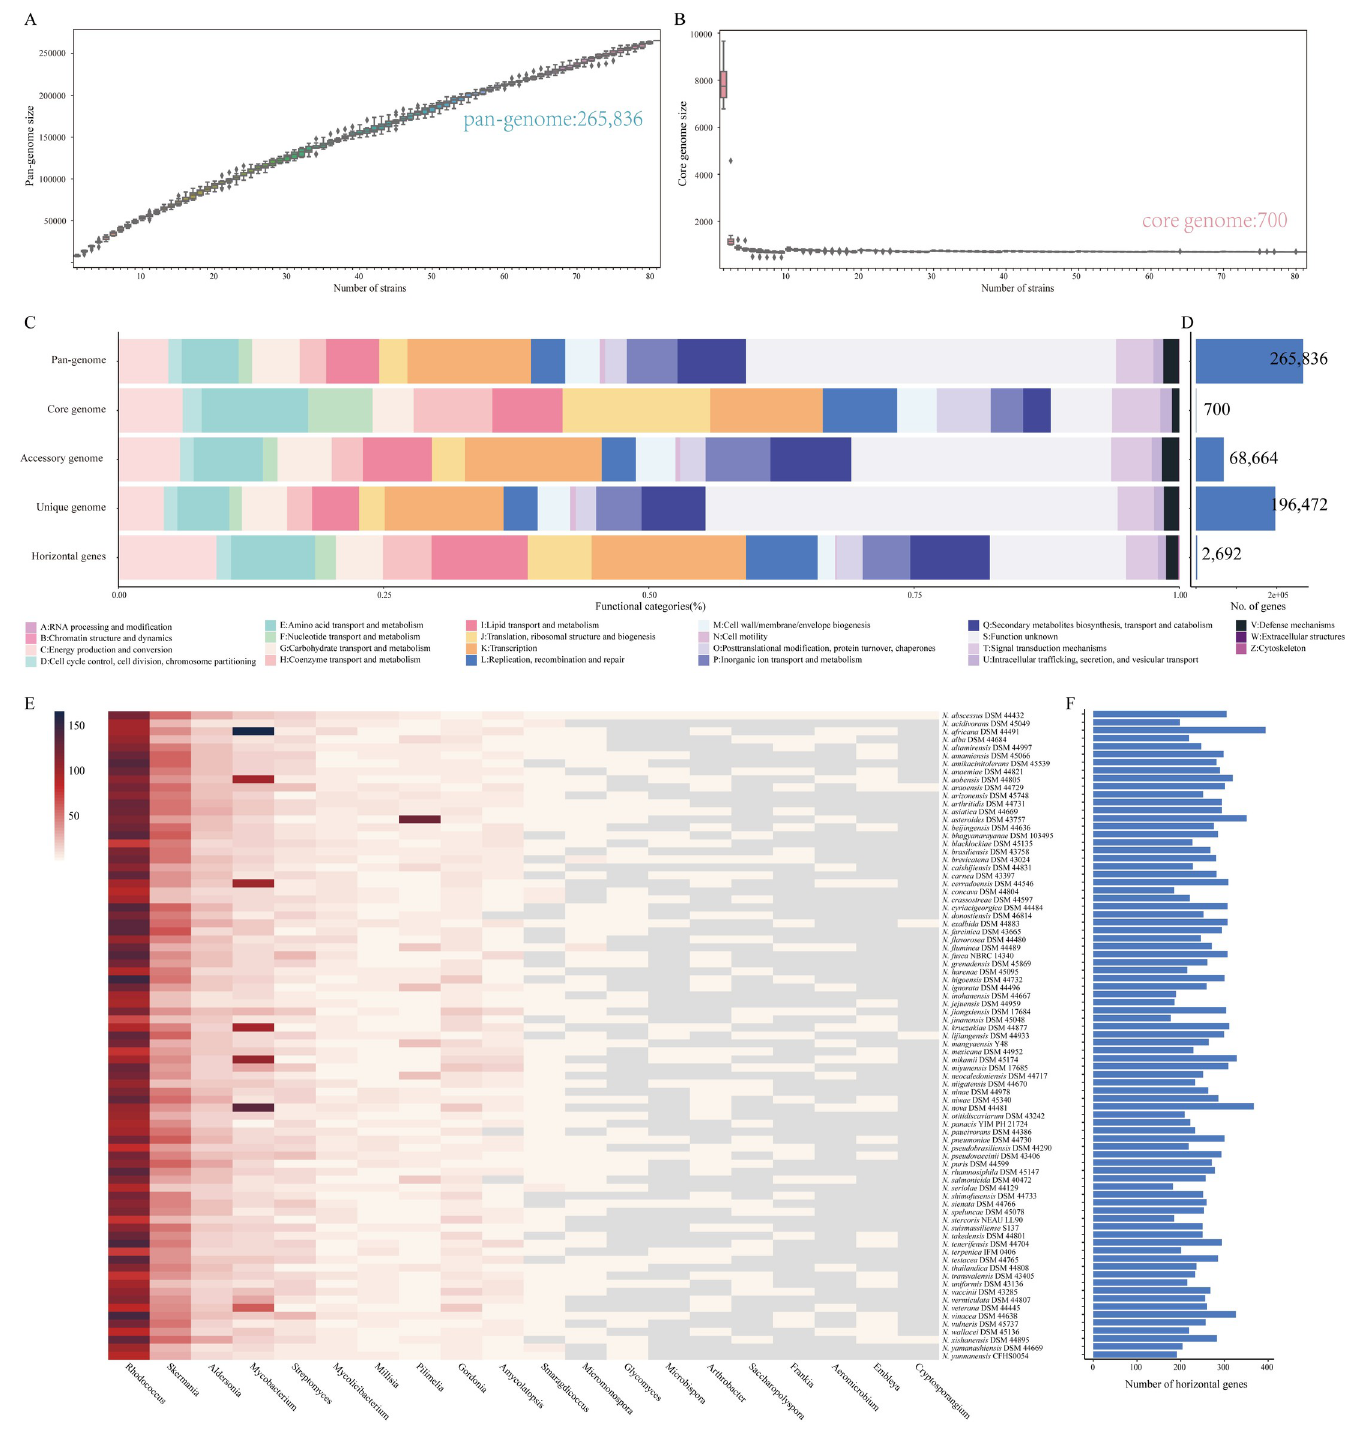
Fig 1. Pan-genome structure and function of type strains of Nocardia . (A) Gene accumulation curves for the pan-genome. (B) Gene accumulation curves for the core genome. The cumulative sizes of the pan-genome and core genome were calculated by type strains without replacement in random order 1000 times and then used to calculate the mean size. Error bars indicate one standard deviation from the mean. Five synonymous species were removed as described in Fig 2 and Table 1. (C) Distribution of functional categories in Nocardia core, accessory, and unique genomes and horizontal genes. (D) The number of gene families in each gene set. (E) The 20 potential donor bacterial genera providing donor genes for HGT. (F) Distribution of horizontal genes acquired in Nocardia spp.